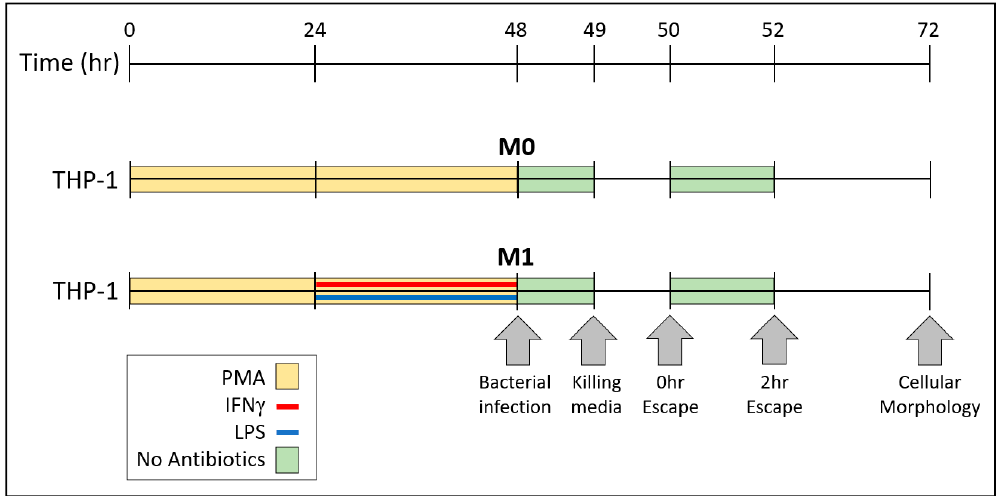
Figure 1. Diagram outlining the protocol of THP-1 differentiation to M0 and M1 macrophages. At 48 h, flow chart of the protocol for bacterial infection, antibiotic protection assay, and bacterial escape in antibiotic-free environments is also indicated. Cellular morphology was determined by microscopy 24 h after bacterial infection, marked at 72 h in the timescale.